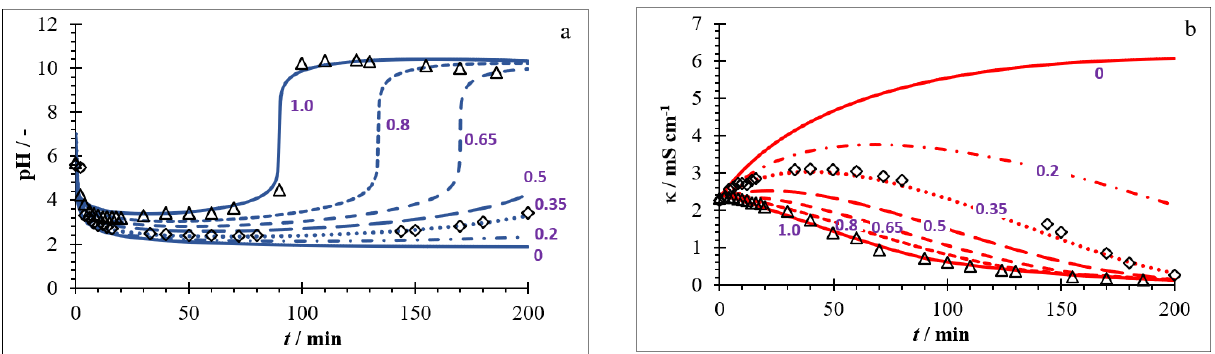
Figure 20. Simulated (lines) and experimental (markers) time dependences of pH ( a ) and electric conductivity ( b ) of a saline solution during ND. The numbers near the curves show the fraction of quaternary fixed amino groups in the AEM, for which the corresponding theoretical curve is calculated. The triangle markers represent experimental data obtained for pristine membrane (AMX, Astom, Japan); the diamond markers represent experimental data obtained for the AMX membrane that has worked in the ND process for about 400 h. Adapted from [15].